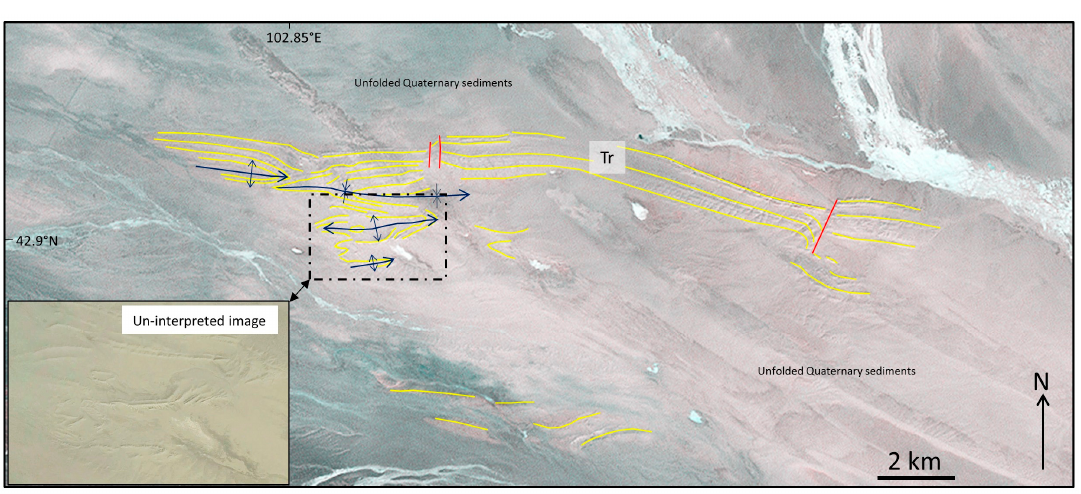
Figure 8. Google Earth (© 2016 DigitalGlobe) image interpretation showing bedding traces (yellow lines) and major fold hinges in Triassic (Tr) sedimentary rocks southwest of Ikh Argalant, southernmost Mongolia. Alluvial and eolian sediments overlap much of the area. Inset shows un-interpreted sub-scene. See Figure 1 for location.